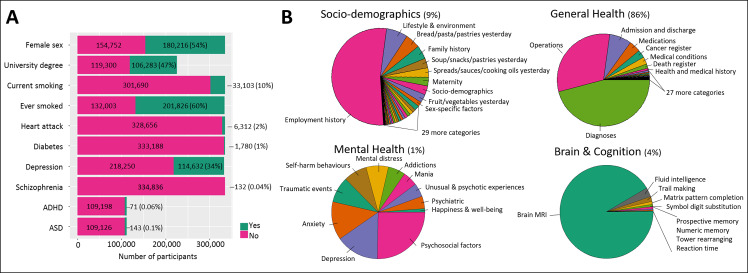
Study overview.(A) Descriptive overview of selected outcomes in UK Biobank. (B) Categories of UK Biobank with the size of pie chart sections indicating the number of included outcomes: socio-demographics (n = 2,057), general health (n = 19,740), mental health (n = 233), brain and cognition (n = 974).